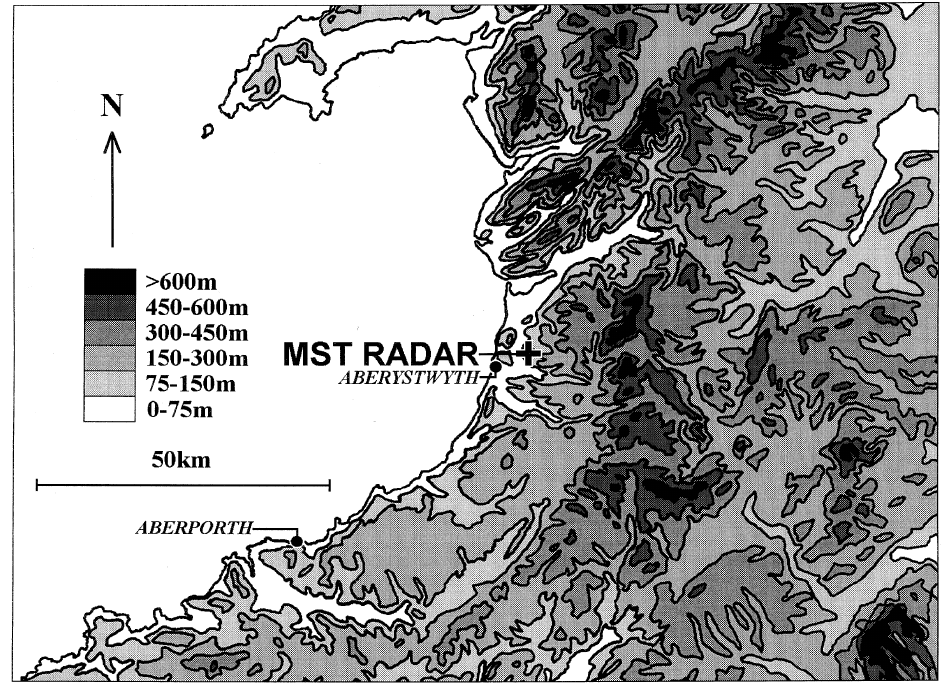
Fig. 3. Map showing mid-Wales, the sea, and the location of the Aberystwyth MST radar. Land height is given in metres. The low-level wind direction for the three case studies can be seen in Figs. 4e, 7e,